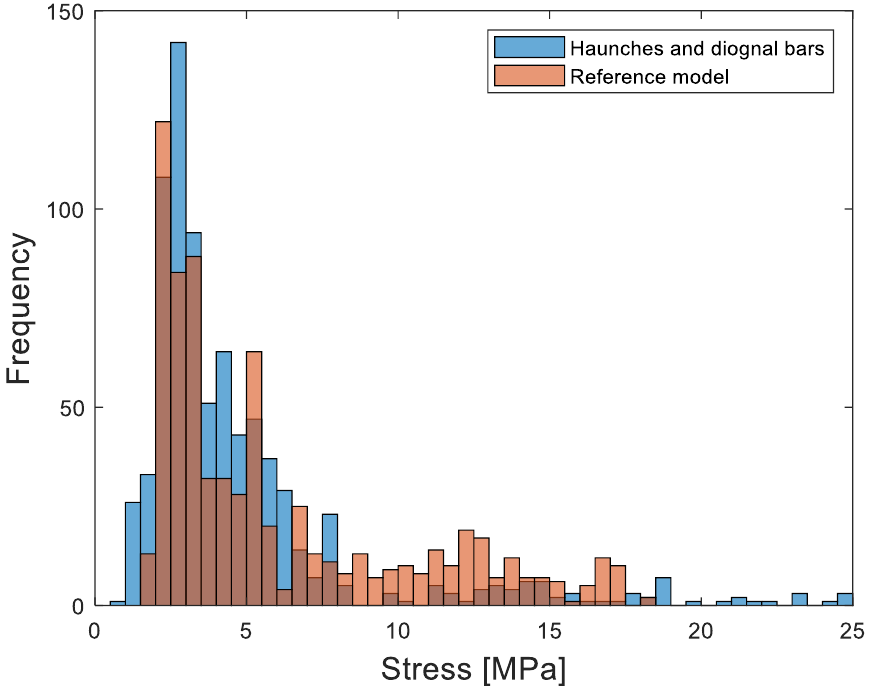
Figure 14. Stress distribution in the wall and slab joints of reference and haunched culverts.